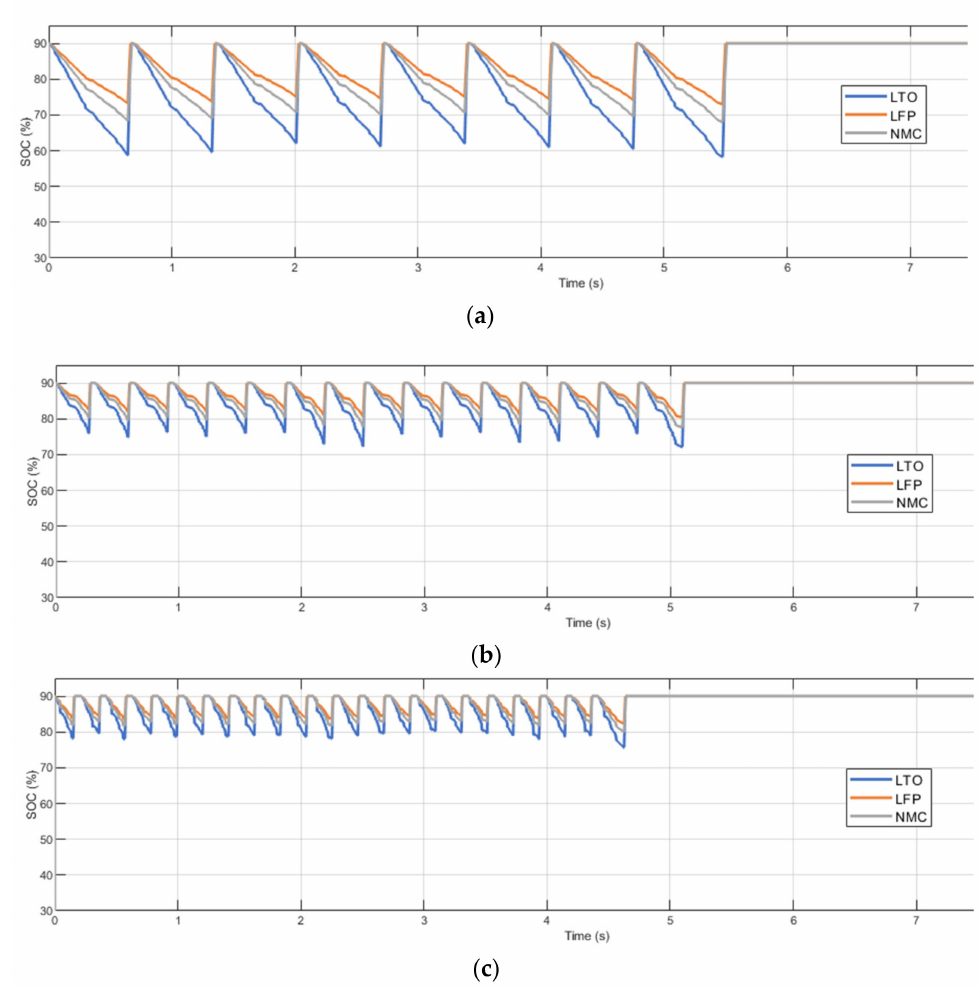
Figure 10. SOC profiles from BCN simulation (1 January). ( a ) Barcelona: Low demand, warm temperature, low charging frequency. ( b ) Osnabrück: High demand, cool temperature, middle charging frequency. ( c ) Gothenburg: High demand, cool temperature, high charging